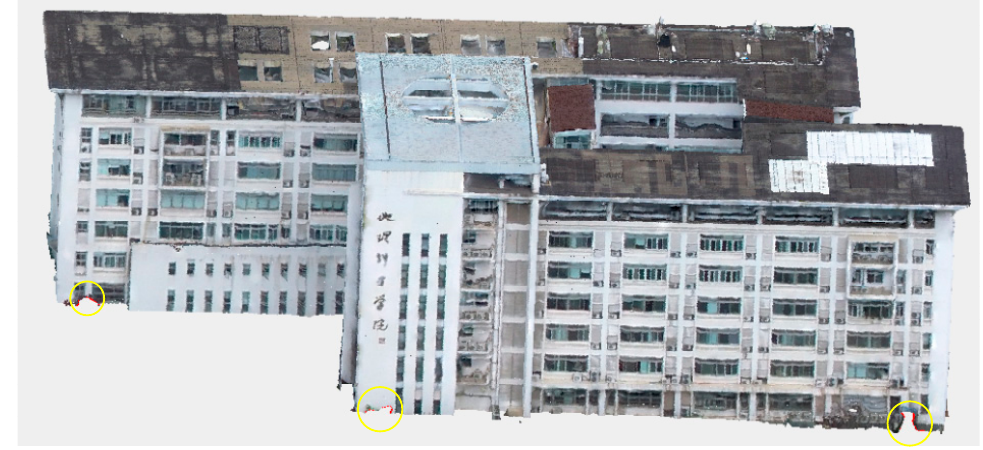
Figure 7. Recognition results of hole boundaries (red points represent the identified border points; yellow circles represent the location of holes).